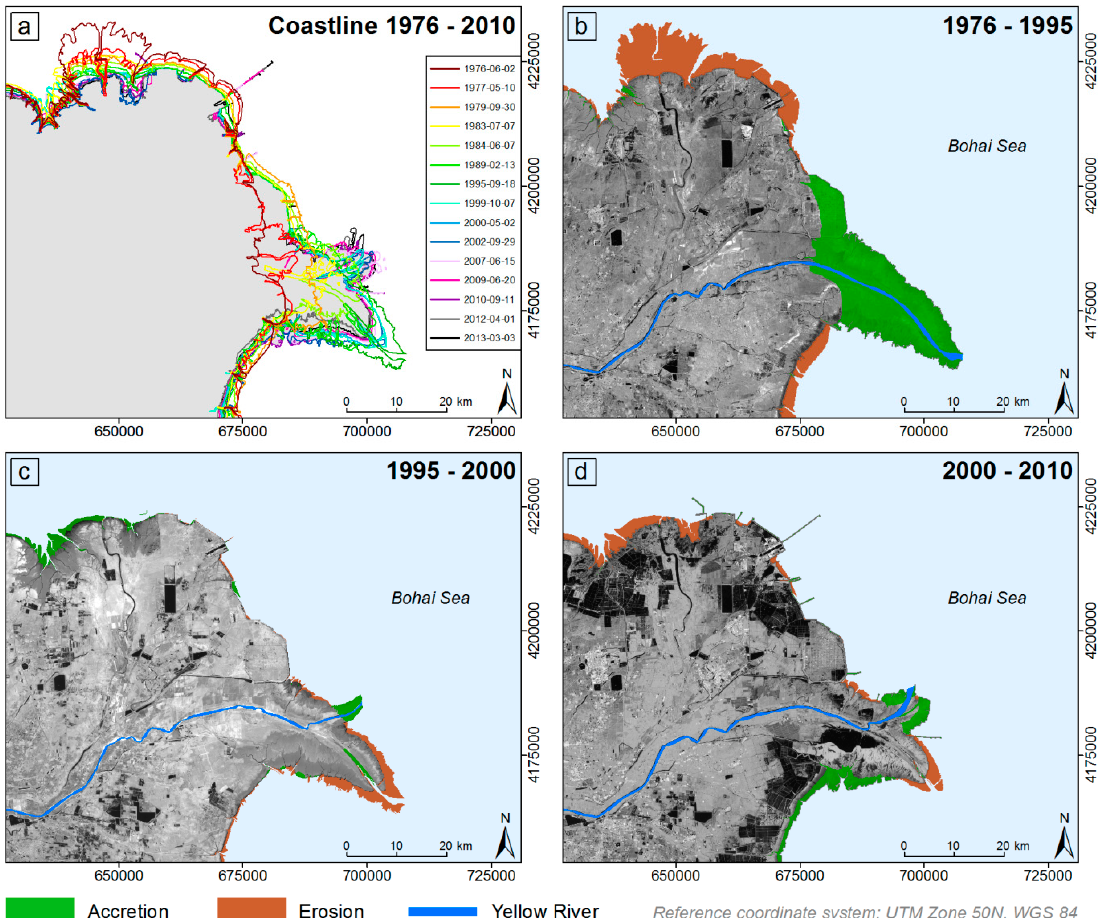
Figure 5. Coastline changes over the course of 34 years in the Yellow River Delta, based on Landsat MSS and Landsat TM satellite data ( a ), as well as shoreline accretion and erosion between 1976 and 2010 ( b–d ).